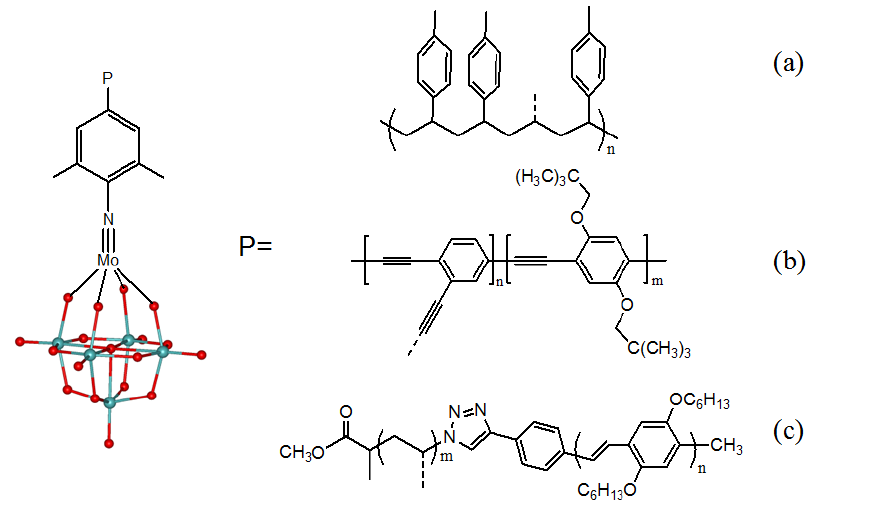
Figure 4. Hybrid polymers based on organoimido-functionalized hexamolybdate as side-chain